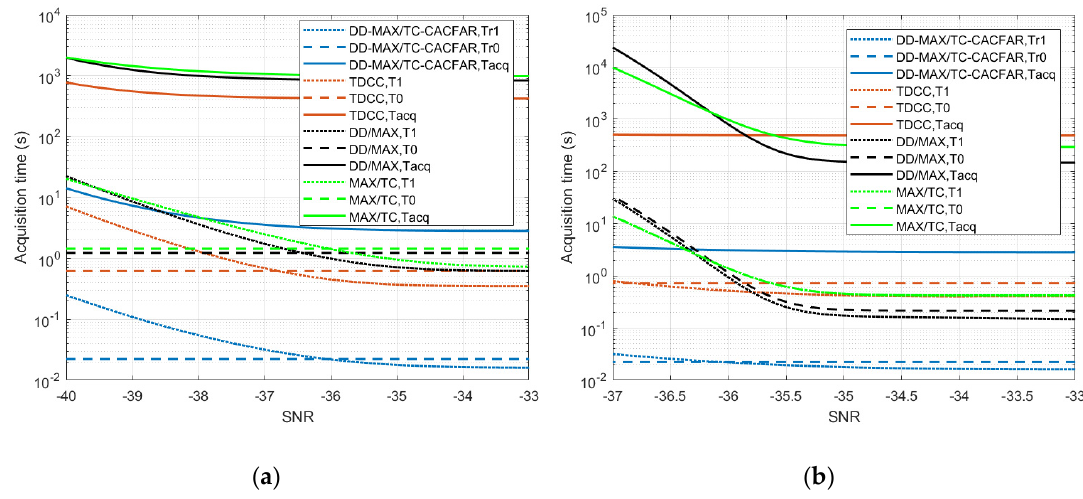
Figure 17. ( a ) Acquisition time versus SNR ( P fa = 0.001) (noise power remains constant); ( b ) acquisition time versus SNR (signal power remains constant).